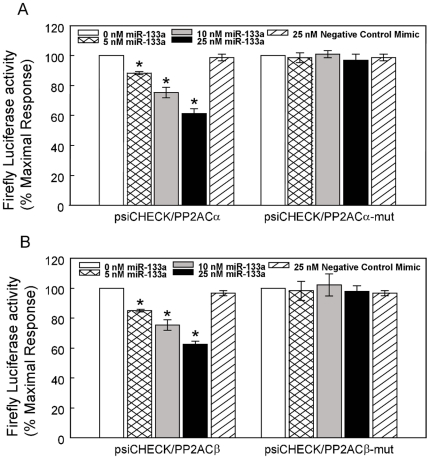
MiR-133 targets both catalytic subunits of the PP2A phosphatase.A. CHO cells were transfected with either the psiCHECK-PP2ACα or psiCHECK-PP2ACα-mut (i.e. the putative miR-133 binding has been mutated) luciferase reporter construct and miR-133, or negative control miRNA mimics at the concentrations indicated. B. Alternatively, CHO cells were transfected with either the psiCHECK-PP2ACβ or psiCHECK-PP2ACβ-mut luciferase reporter construct and miR-133, or negative control miRNA mimics at the concentrations indicated. Twenty-four hours following transfection, luciferase activities were measured. Renilla luciferase activity was normalized to firefly luciferase activity and mean activities ± S.E. from three-five independent experiments are shown (*p<0.05 vs. 0 nM).